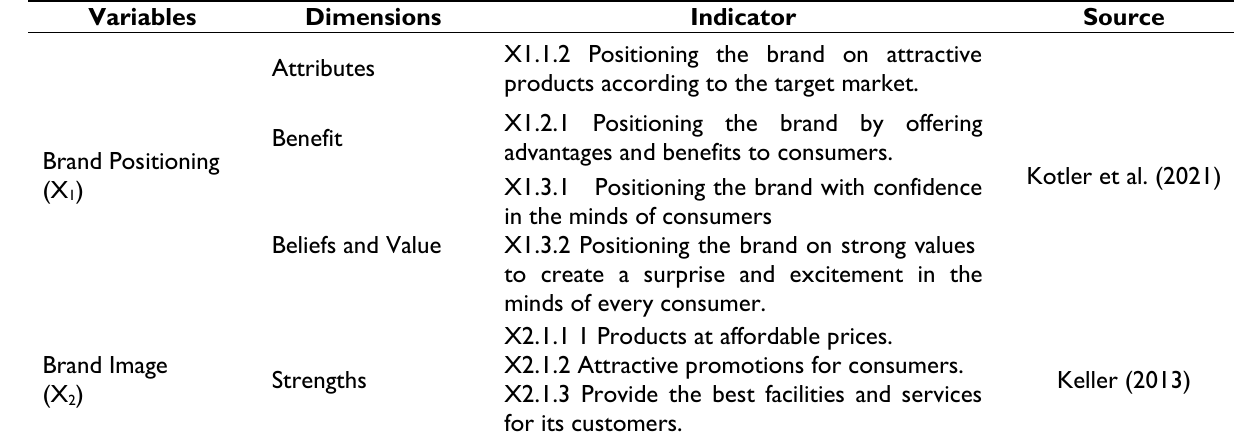
Table 1. Definition of Operational